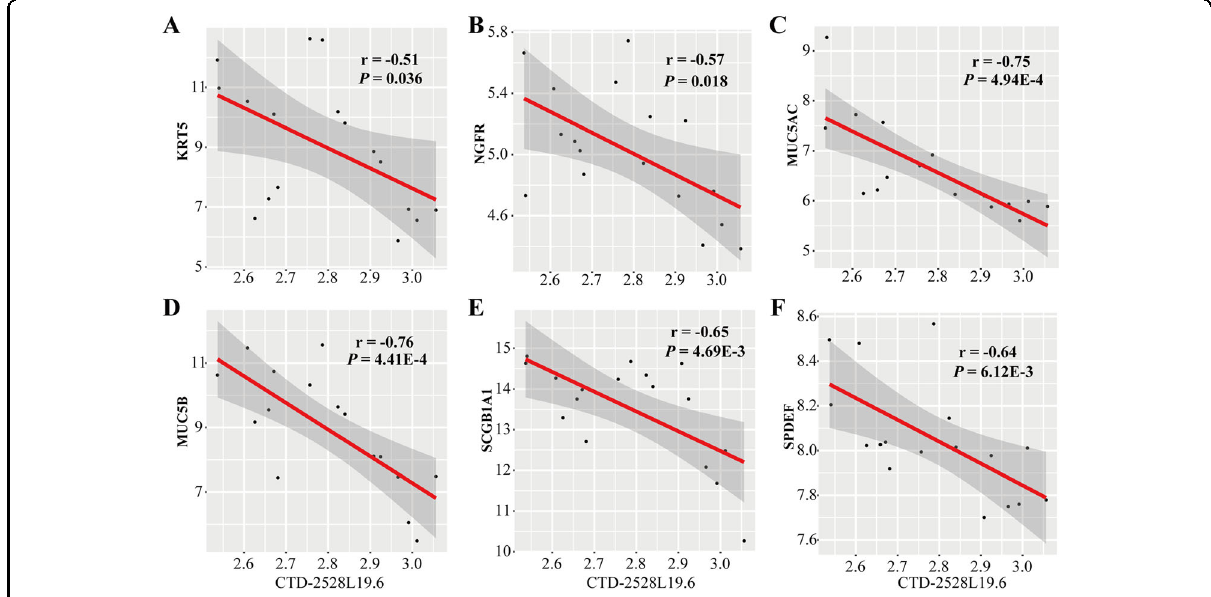
Fig. 5 Correlation between CTD-2528L19.6 and six IPF cell markers in IPF patients. A - F The correlation relationship between CTD-2528L19.6 and six IPF cell markers ( KRT5 , NGFR , MUC5AC , MUC5B , SCGB1A1 , SPDEF ) was tested by Pearson correlation test. The fi tting model was constructed using the “ lm ” method function in R package